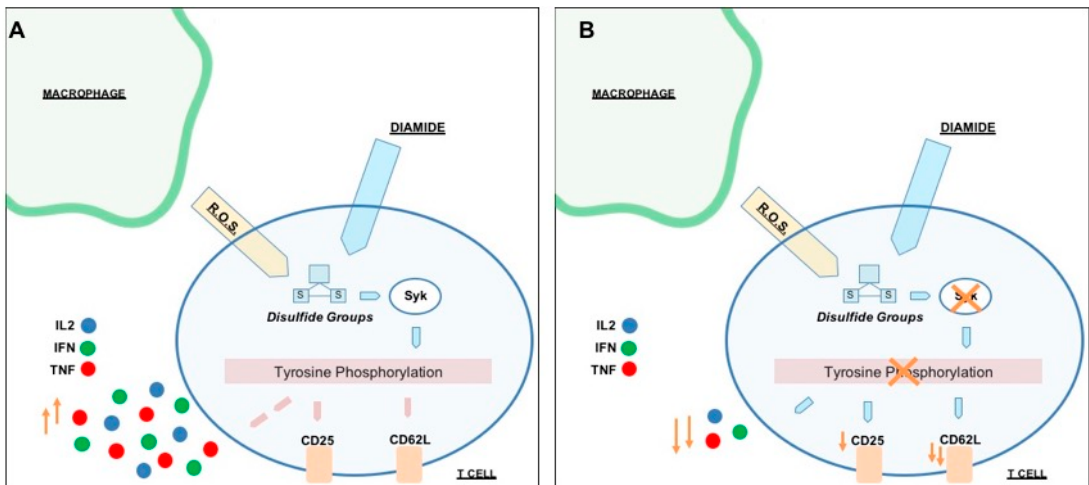
Figure 8. Model of the cysteine redox regulation of the Tyr phosphorylation in human purified T cells. ( A ) Different sources, such as macrophages, can produce oxidative species. Oxidation of thiol groups may directly induce the Syk activation. This kinase is essential in the consequent phosphorylation and functional phenomena. These molecular events involve several different effectors and generate a cellular response on the T cells receptors. ( B ) Syk inhibition blocks the ROS-trigged phosphorylation flow and further affected CD25 and CD62L receptors and cytokine liberation.